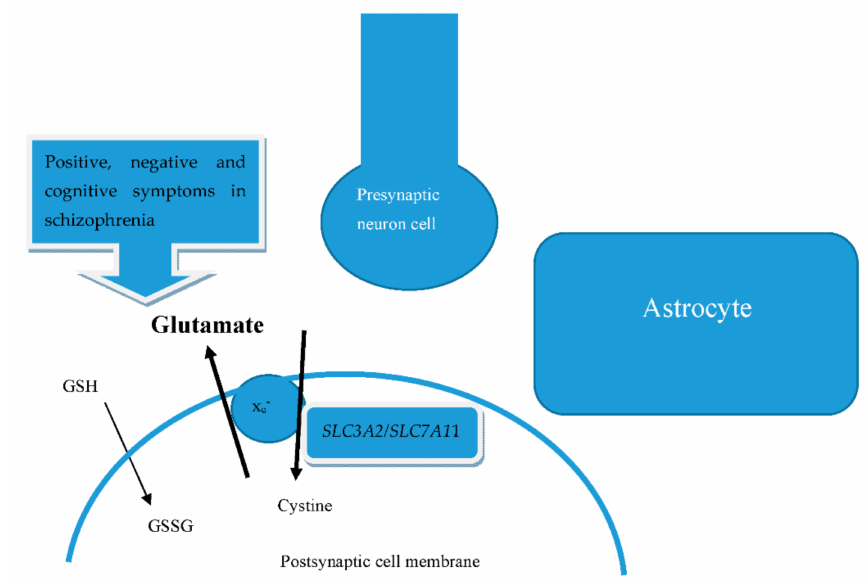
Figure 1. Biomolecular mechanisms between glutamate and system x c −